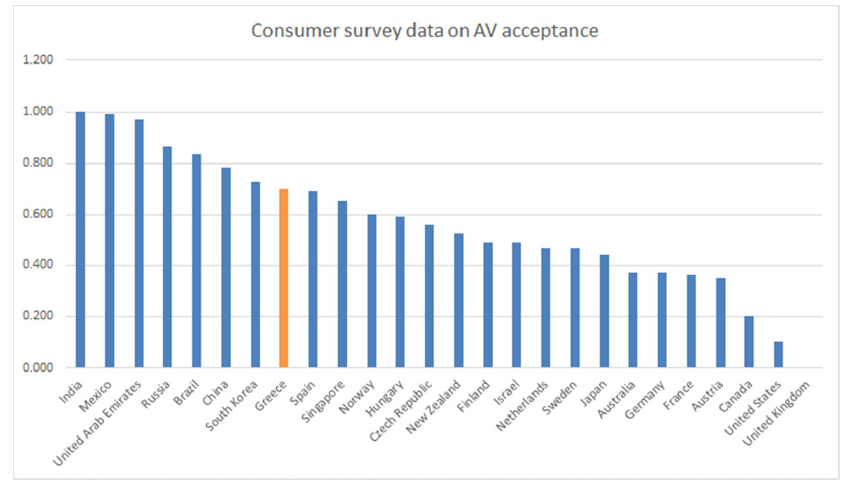
Figure 1. Greece’s AVRI listing in Pillar IV—Consumer opinions.